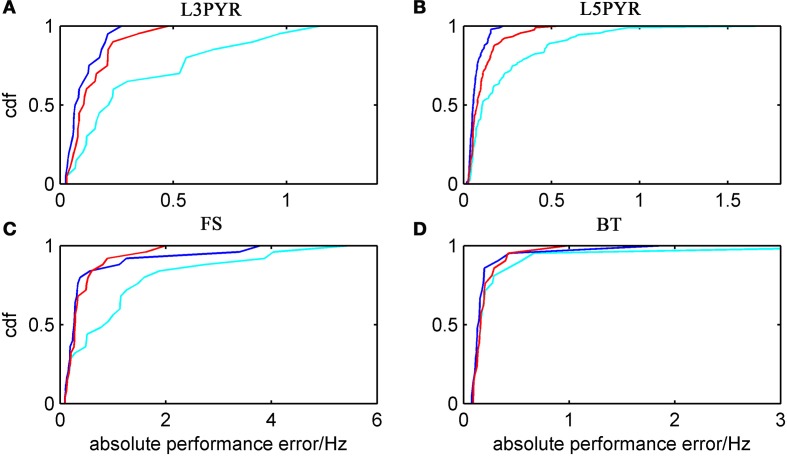
Absolute prediction error for a large physiological data pool from different neuron types recorded in-vitro. For the 4 neuron types (A: layer-3 pyramidal cell, B: layer-5 pyramidal neuron, C: fast-spiking and D: bitufted interneuron), the empirical cumulative distribution of the absolute prediction error is shown (ν0: cyan, ν0 + ϵ2 ν2: blue, d〈 νEIF 〉w: red). Absolute prediction error averaged across σIsyn = [100, 300] pA and μIsyn = [r − 15, r − 10, r − 5, r, r + 5, r + 10, r + 15] pA with r denoting the cell-specific rheobase, and given in Hz. N(L3) = 20, N(L5) = 90, N(FS) = 25, and N(BT) = 21.